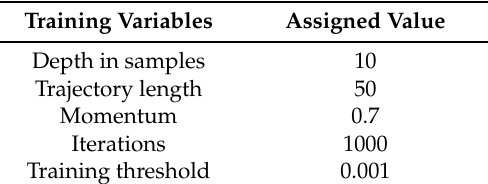
Table 3. Configurations of TLRN during training.